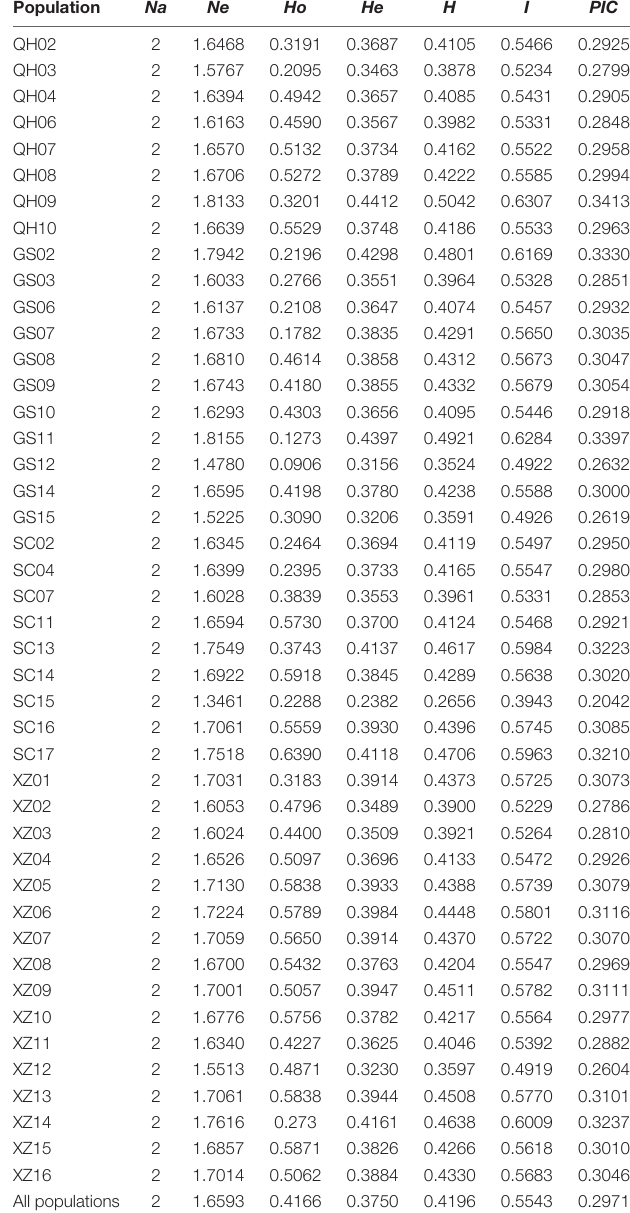
TABLE 1 | Intra-population genetic diversity of 44 E. sibiricus